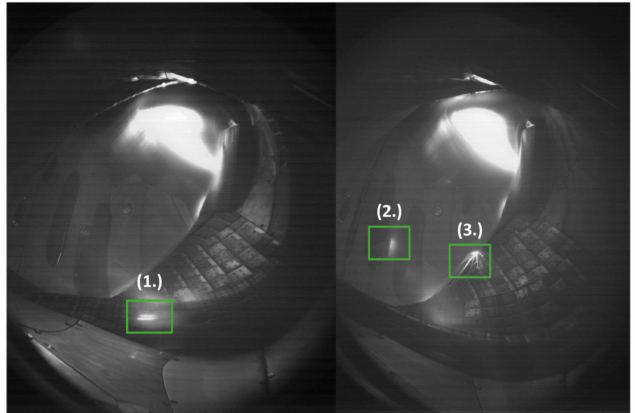
Figure 1. Three examples of hot-spots detected in the images of the visible video diagnostics. ( 1 .) A hot-spot on the shielding of the magnetic diagnostics, created by the misconfiguration of the magnetic field structure. ( 2 .) A hot-spot on the reciprocating probe. ( 3 .) A hot-spot made from debris falling into the